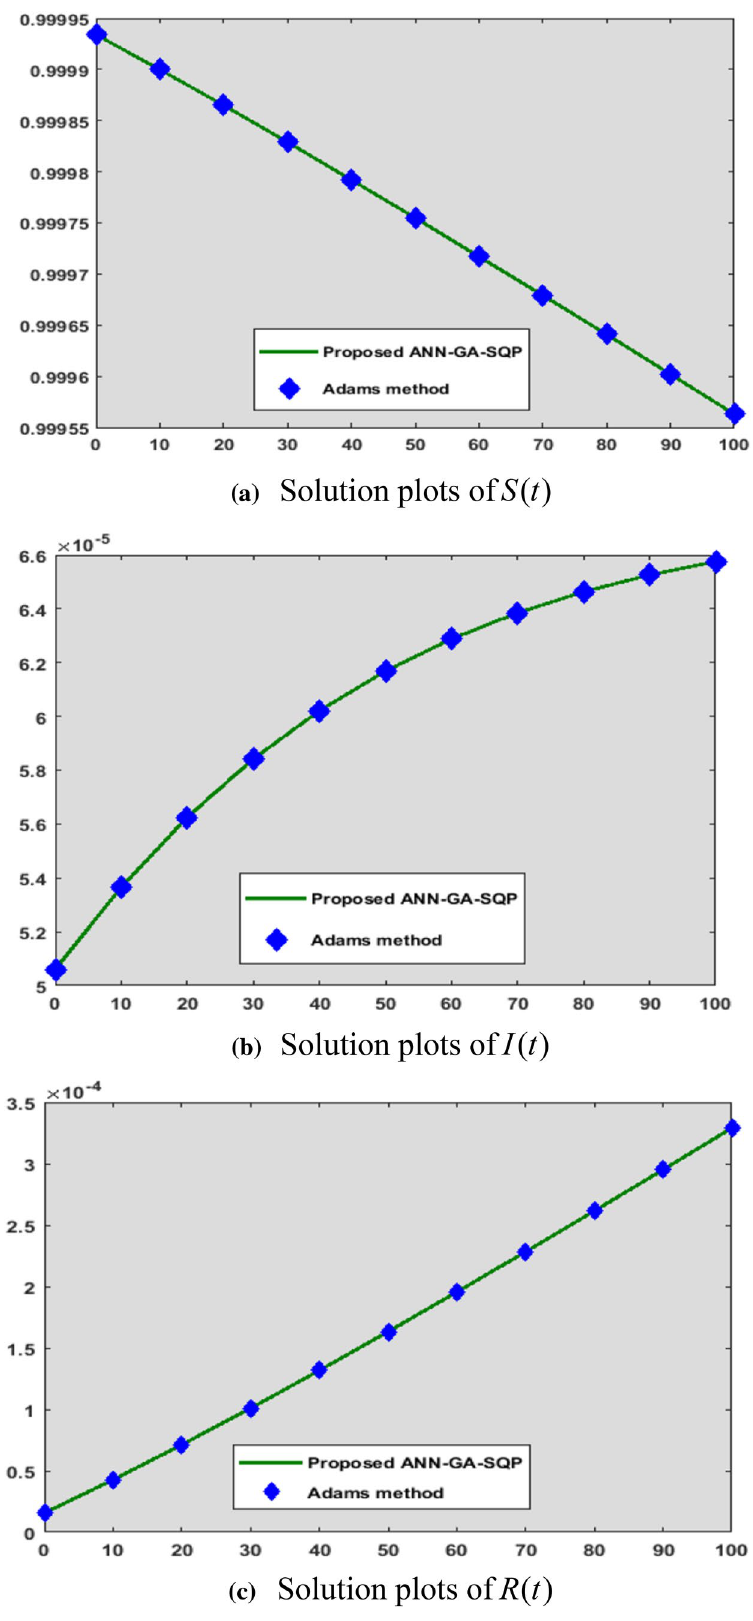
Fig. 8 Comparison Analy- sis of ANN-GA-SQP with Adam numerical technique for COVID-19 SIR